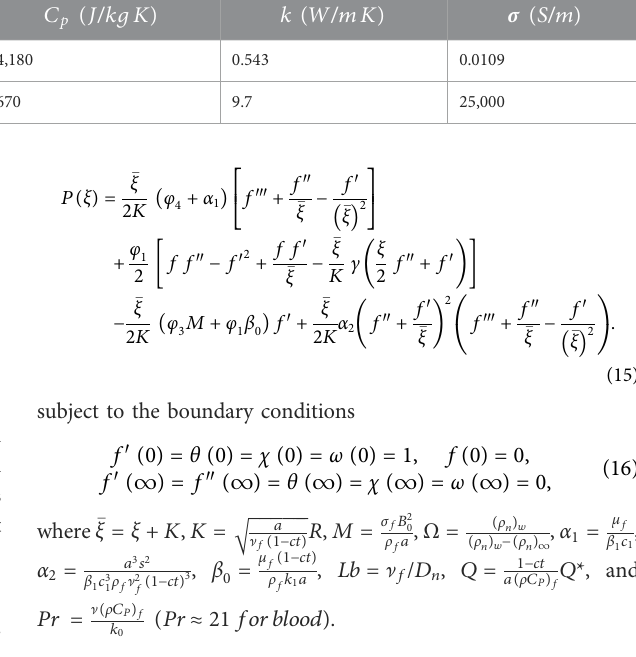
TABLE 1 Thermophysical characteristics of Fe 3 O 4 magnetite nanoparticles and blood (Alyousef et al., 2023; Yasmin et al., 2023a). Thermophysical